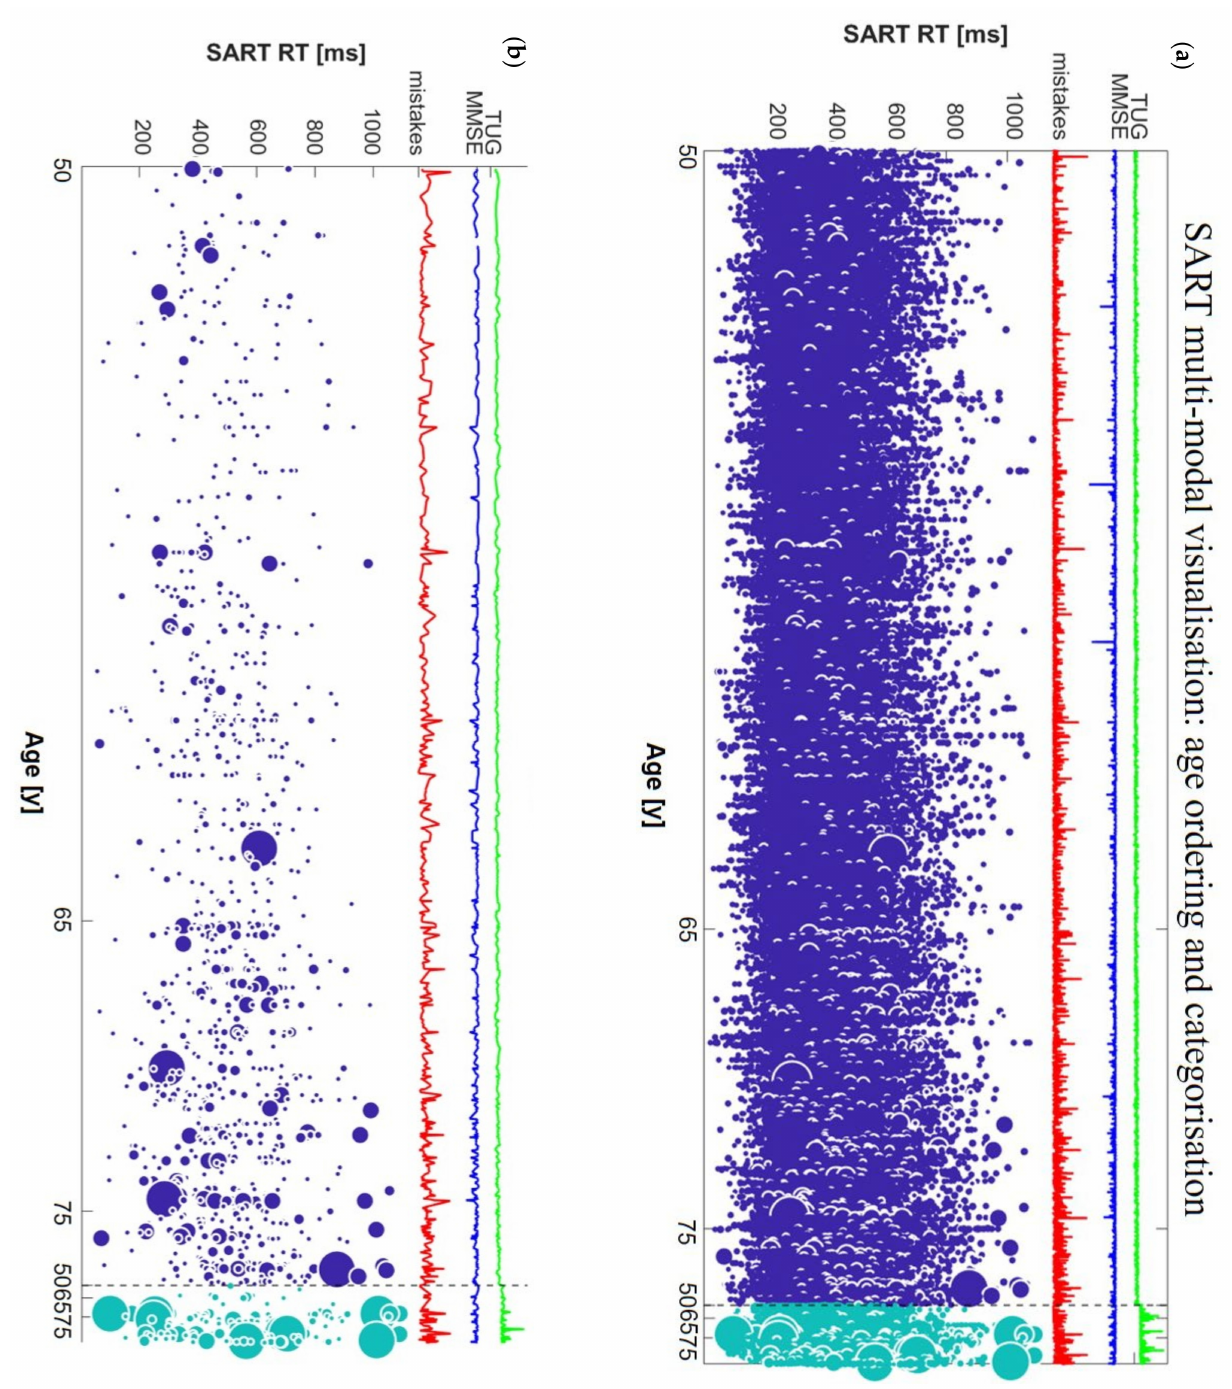
Figure 2. Multimodal visualisation of SART data, ( a ) ordered by age within baseline TUG categories and ( b ) ordered by age within TUG categories with thresholding applied. Dark blue spots indicate participants with TUG 1 < 12 s, light blue spots indicate participants with TUG 1 ≥ 12